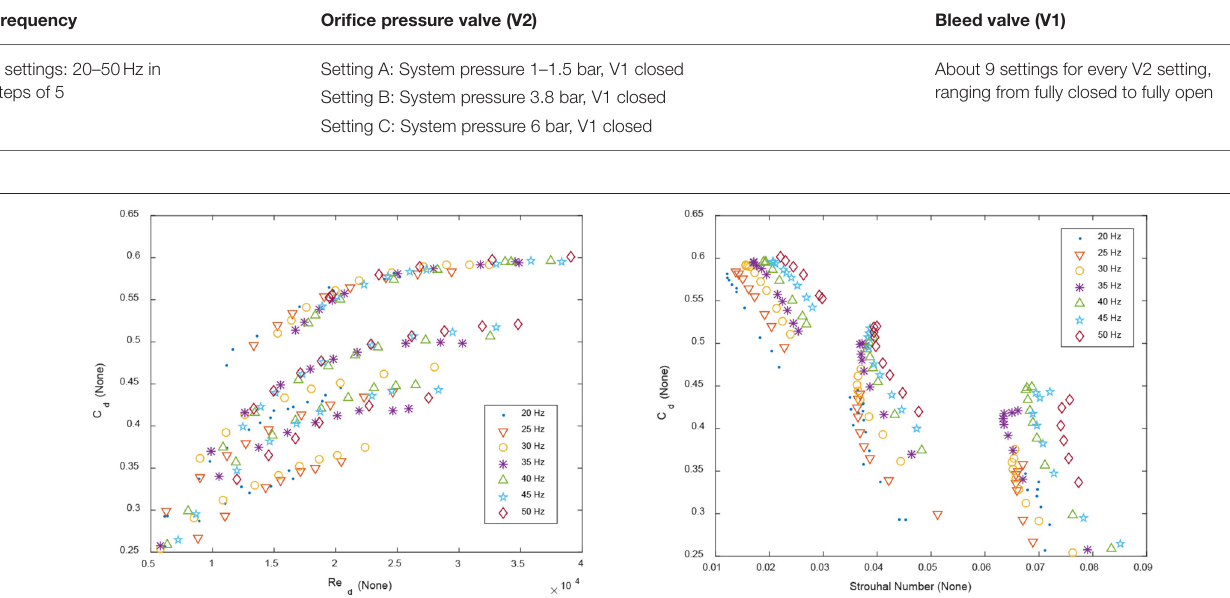
TABLE 1 | The Test Plan used to collect the 189 data points generated by the pulsating flow apparatus. Frequency